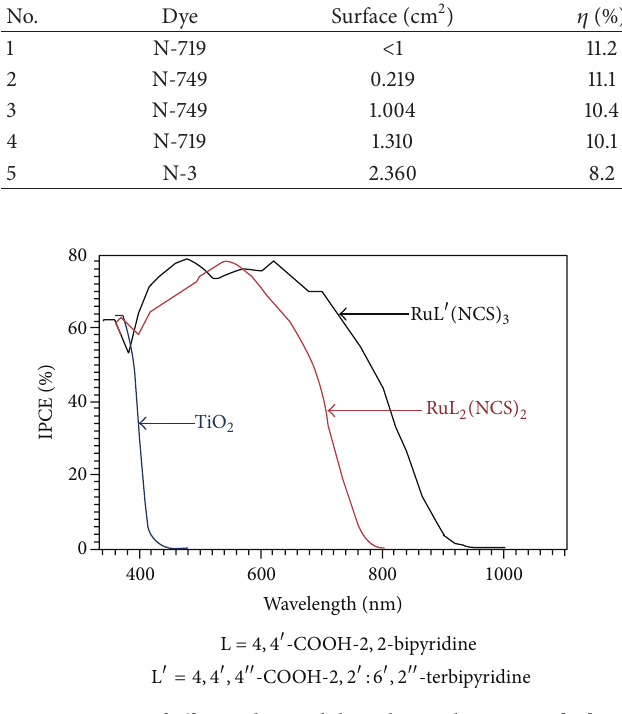
Figure 2: IPCE of efficient dyes and their chemical structures